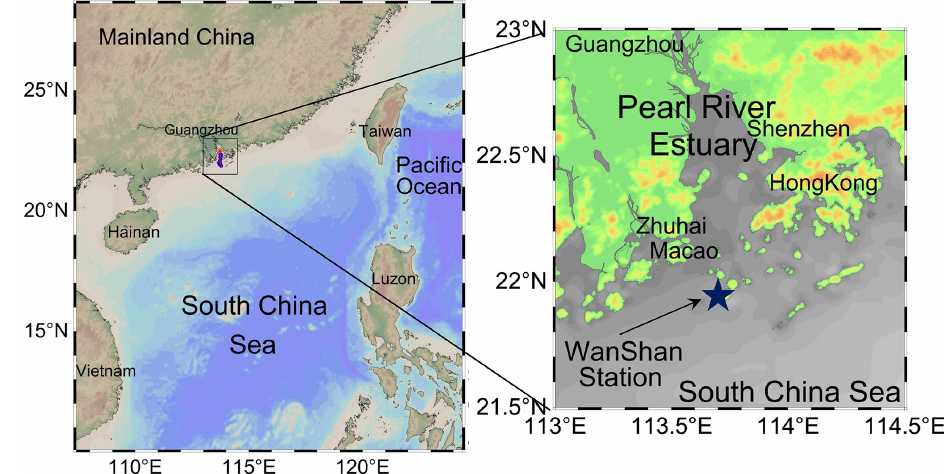
Figure 1. Geographic map of the Pearl River estuary and the adjacent northern South China Sea. The filled star in the enlarged panel is the monthly time series station (21.9 ◦ N, 113.8 ◦ E) near Wanshan Island from June 2018 to June